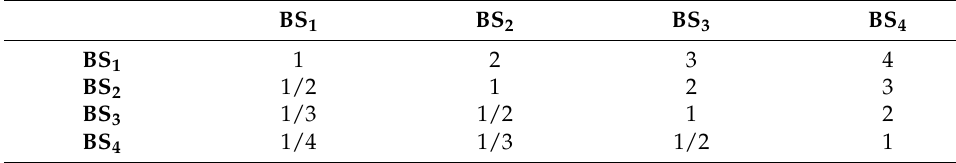
Table A1. The pairwise comparison matrix C 1 .